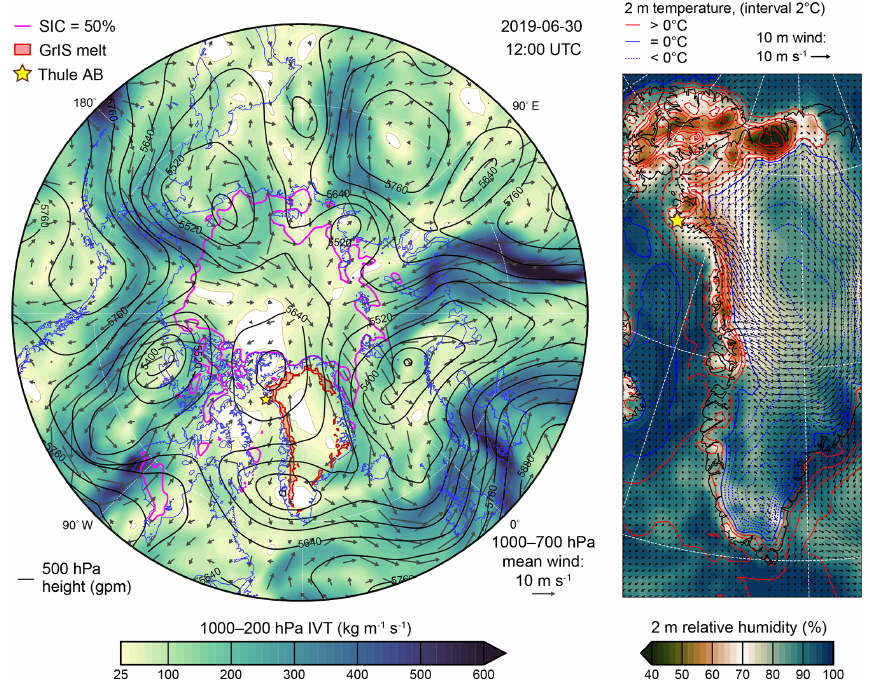
Figure 7. Synoptic pan-Arctic (left panel) and regional Greenland-focused (right panel) atmospheric conditions during an anomalously warm period on 30 June 2019, when a ridge over northwest Greenland directed downsloping air toward the observing site at Thule Air Base. The synoptic map shows integrated water vapor transport (IVT), 1000–700hPa mean wind (arrows), and 500hPa height (gray isolines), the 50% sea ice concentration (SIC) boundary (pink line), and areas of Greenland ice sheet (GrIS) surface melt (red shading). Areas in white have less than 25kgm − 1 s − 1 IVT. The regional map on the right shows 2m relative humidity (primary shading) and temperature (red and blue isolines) along with 10m wind (arrows). All data are from MERRA-2 (Stein et al., 2015; Gelaro et al., 2017) except for ice sheet surface melt, which is from the NSIDC MEaSUREs Greenland Surface Melt daily data set derived from passive microwave satellite observations (Mote,